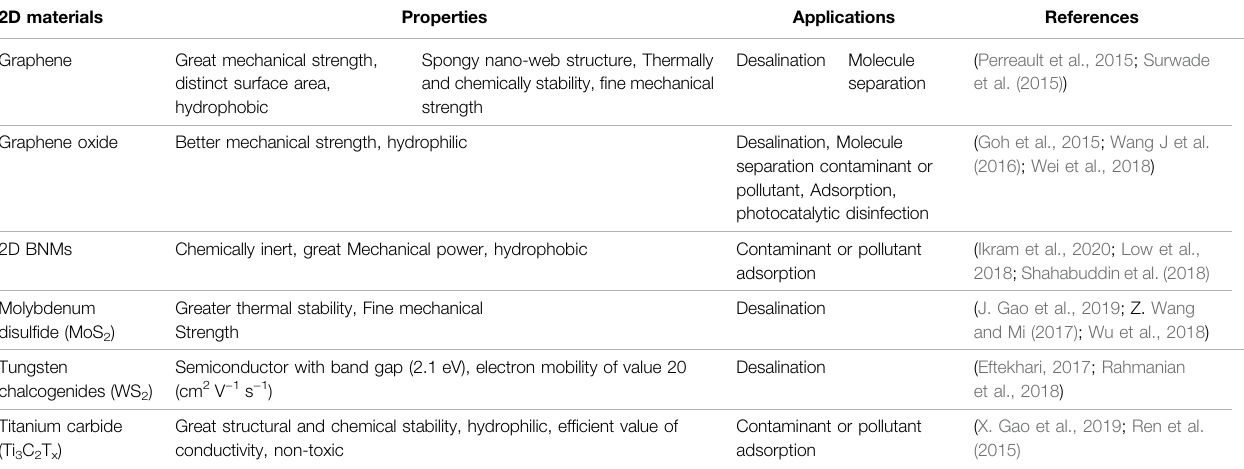
TABLE 2 | Two-dimensional nanomaterials applications for water treatment.